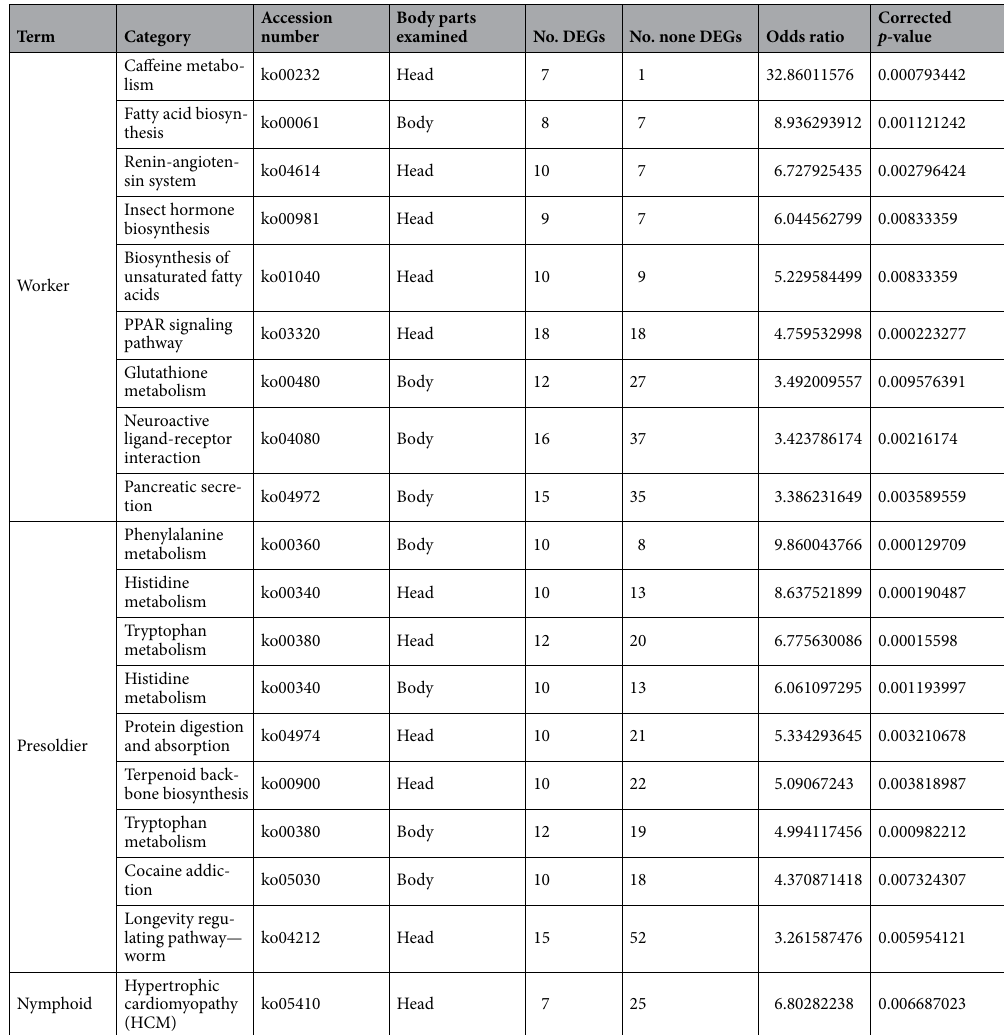
Table 4. Kyoto Encyclopedia of Genes and Genomes (KEGG) terms specifically observed during each